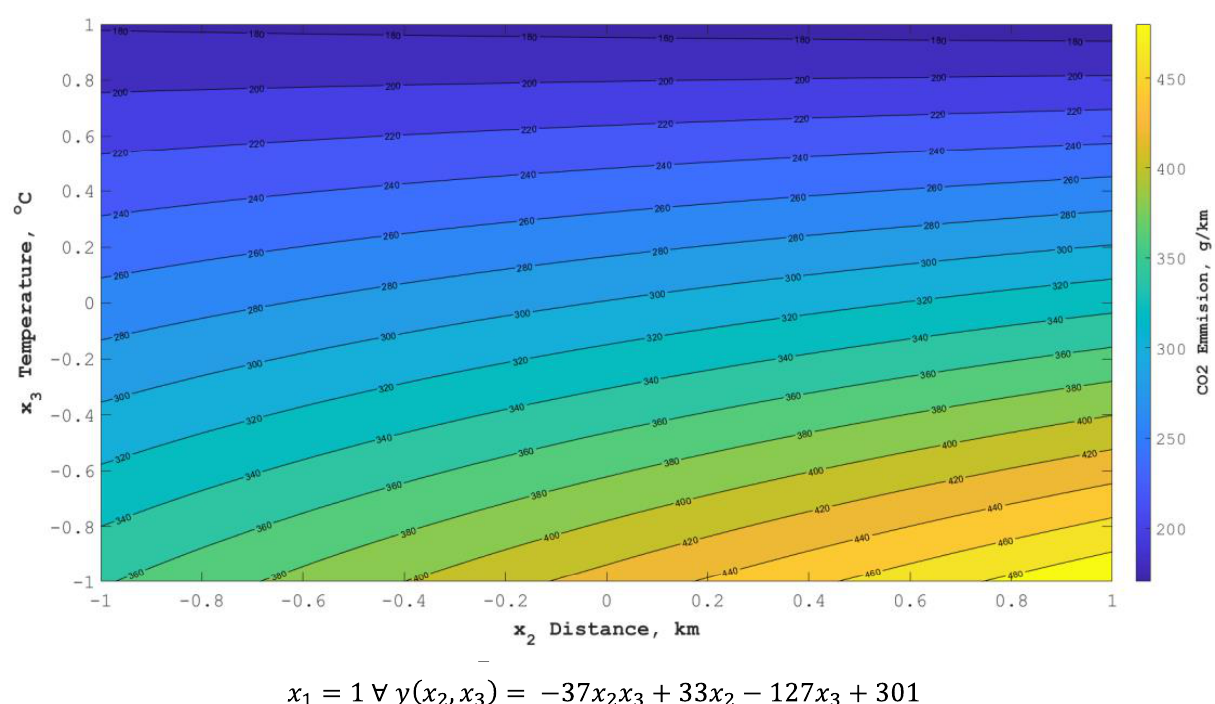
Figure 4. Change in CO 2 emissions depending on the variability of factors x 2 and x 3 for a vehicle (ICE) moving for 10 min (x 1 = 1).